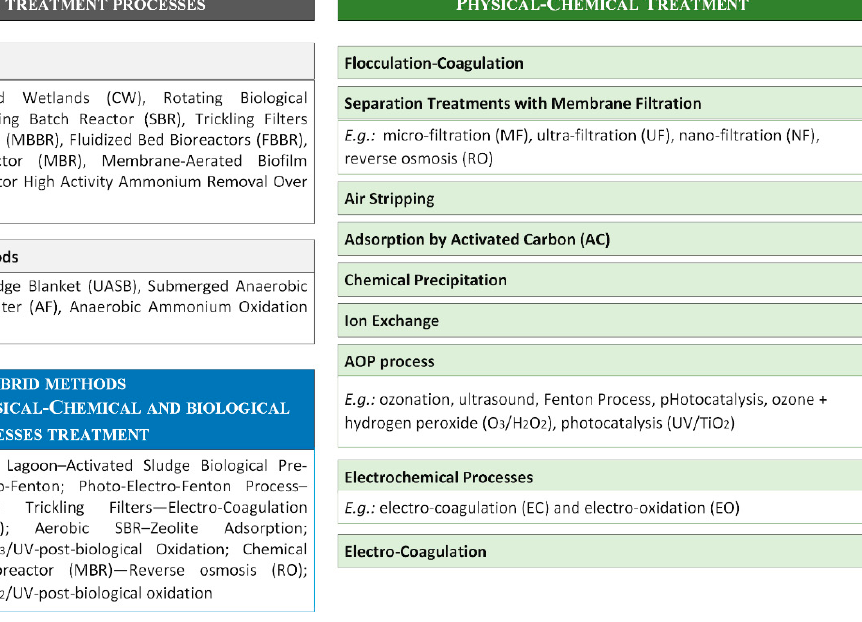
Figure 1. Classification of leachate treatment methods, based on [3,4]. Table 1. Characteristics of leachate depending on its age [12].